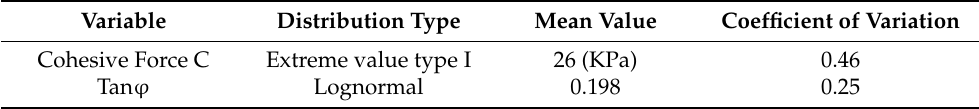
Table 3. Distribution form of random variables.